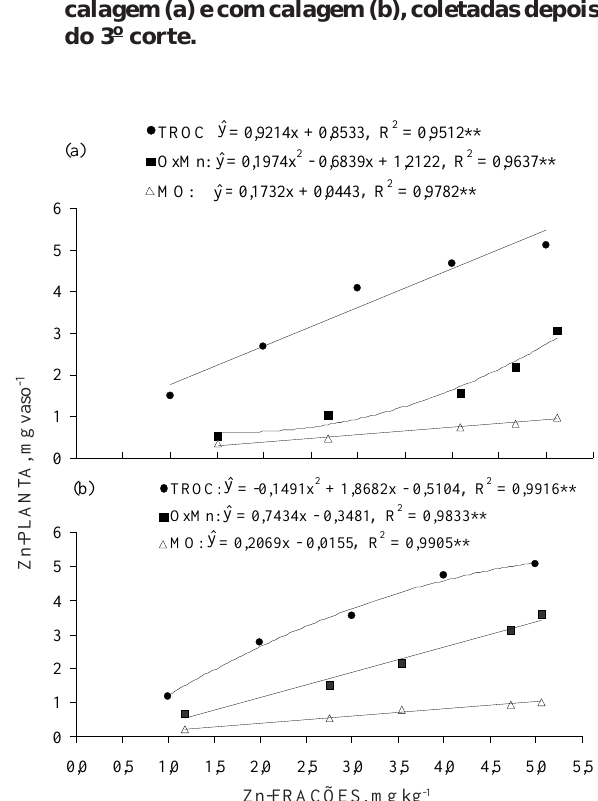
Figura 4. Relação entre o zinco na parte aérea da planta (1 o corte) e as frações de zinco em amostras de solo sem calagem (a) e com calagem (b), coletadas antes do